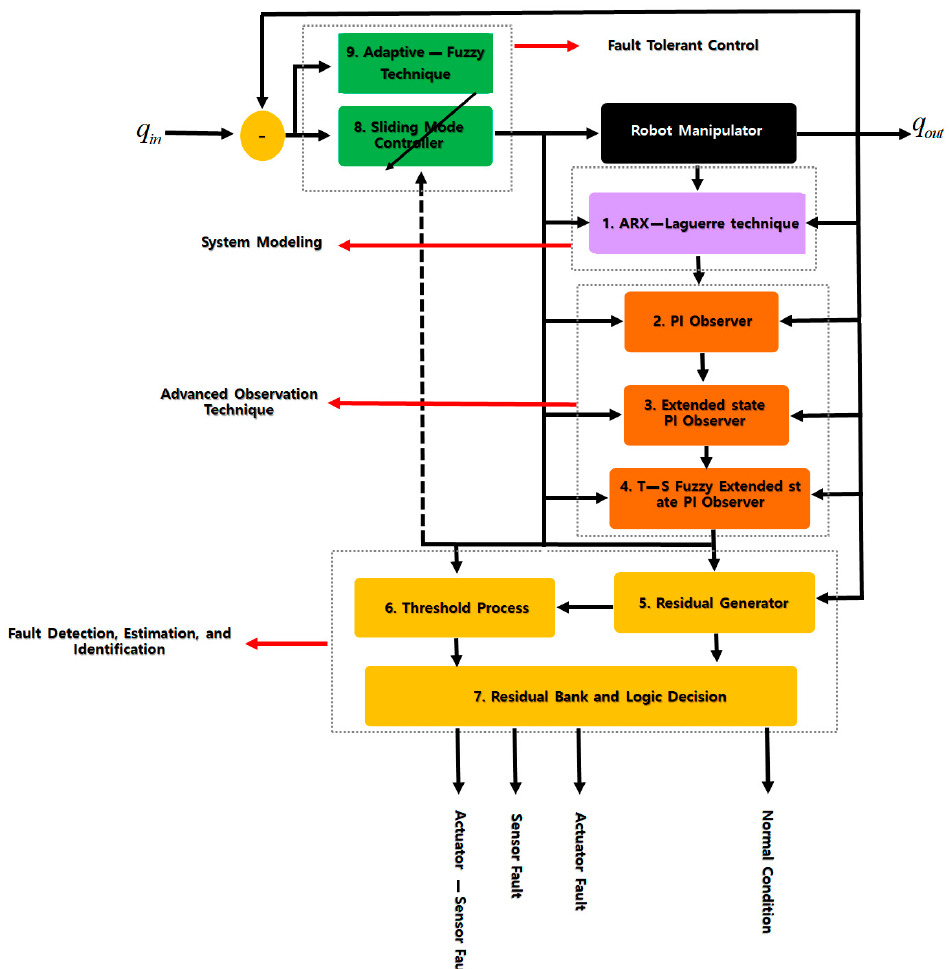
Figure 1. The proposed technique for fault detection, estimation, identification, and tolerant control.